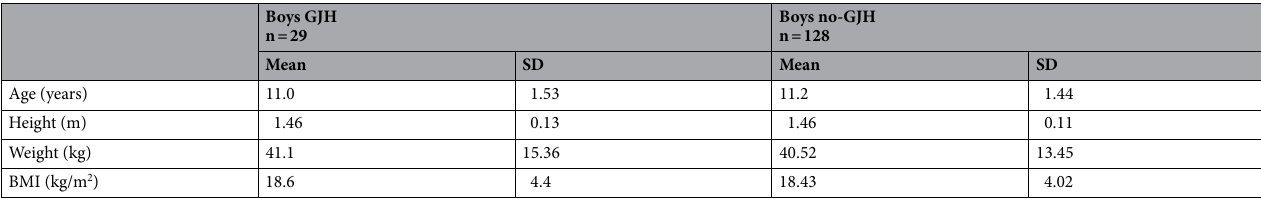
Table 2. Characteristics of boys with (GJH) and without (no-GJH) generalized joint hypermobility (n = 157).